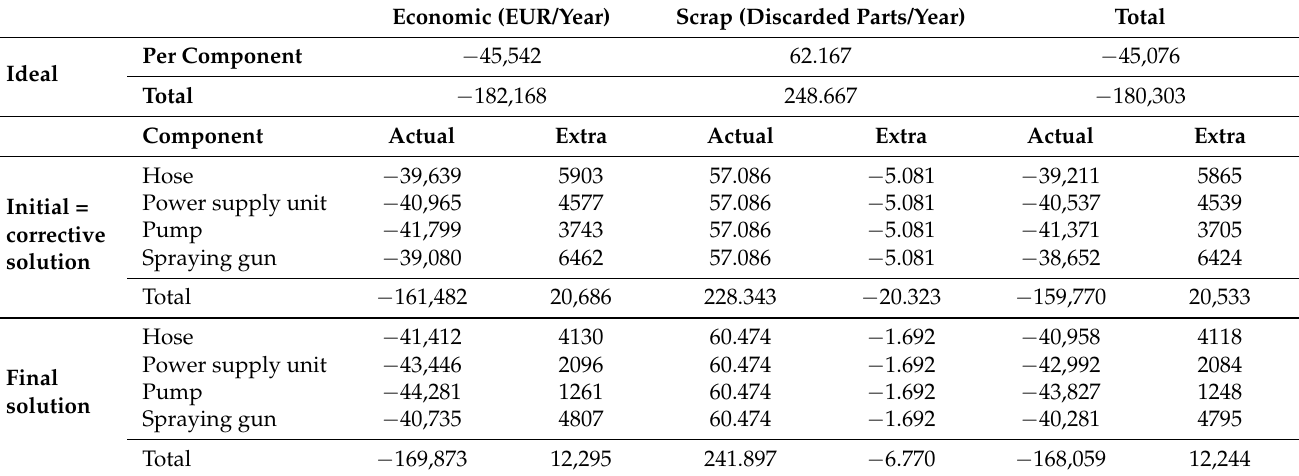
Table 5. KPIs yielded from training the model for the spraying cabin